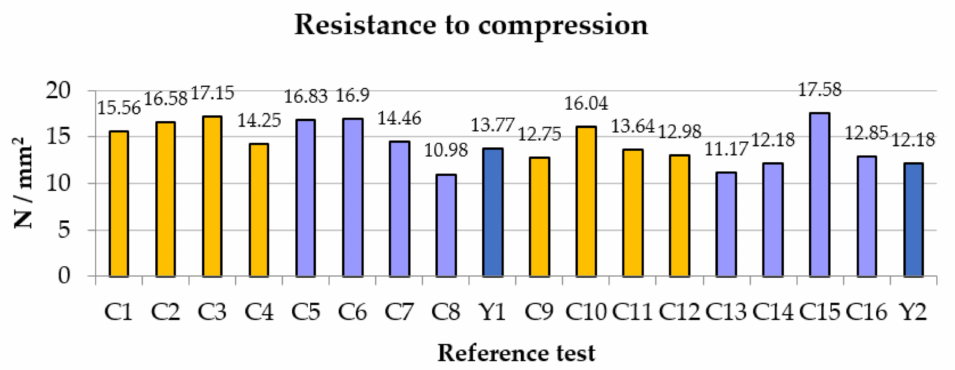
Figure 5. Comparative results of the compressive strength.